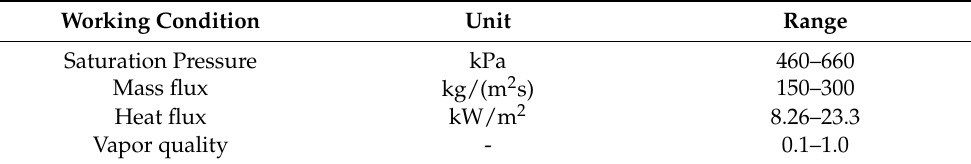
Table 4. Working condition for this experimental study.